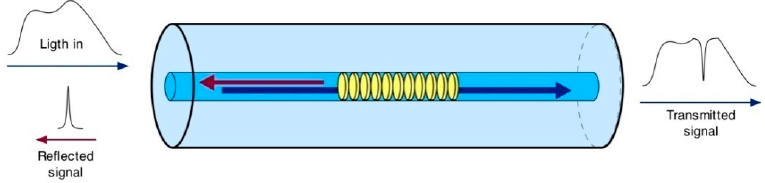
Figure 1. Working mechanism of a FBG sensor.